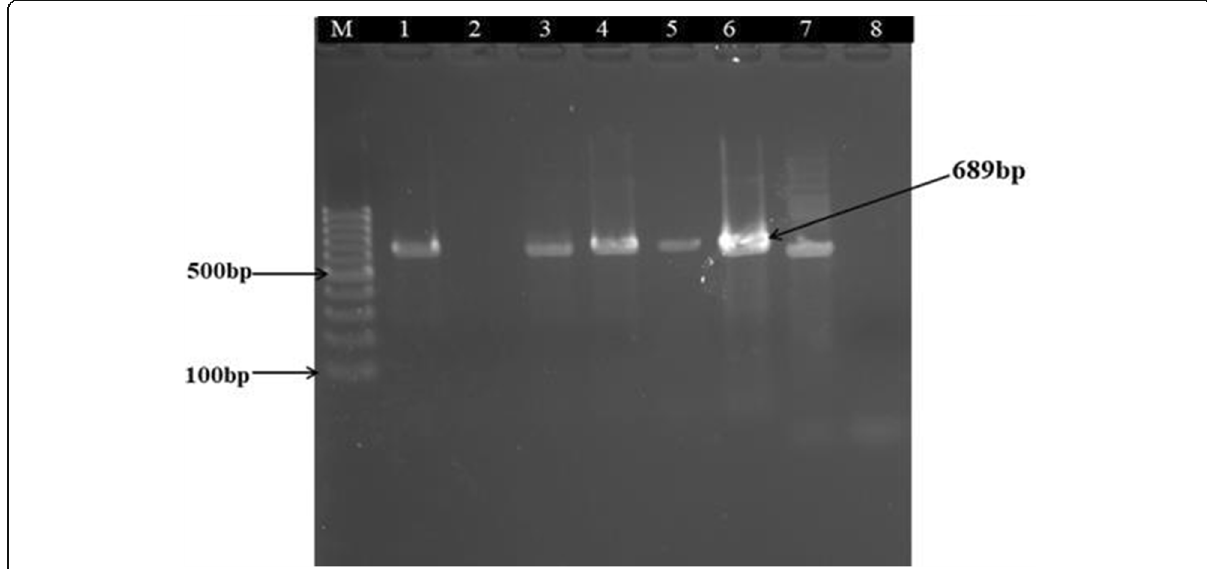
Fig. 4 Agarose gel electrophoresis analysis for the mecA gene in S. aureus isolates. Lane M = l00-bp DNA marker, lanes 1 – 7 = test